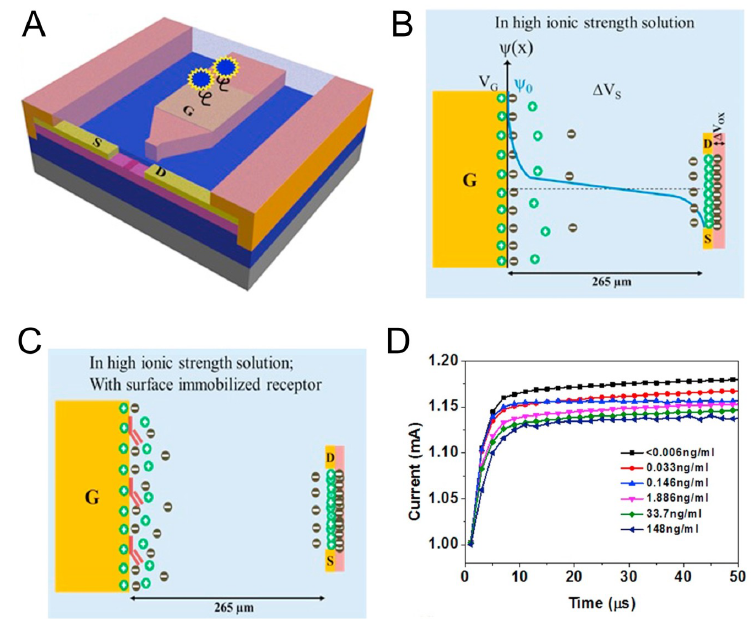
Figure 2. ( A ) Schematic illustration of the AlGaN/GaN High Electron Mobility Transistor (HEMT) sensor consisting of a gate electrode opening and channel opening separated by a fixed distance. ( B ) Potential distribution across the solution when gate voltage and transistor bias are applied. ( C ) Illustration of the charge distribution in the electric-double layer (EDL) gated HEMT structure when the receptor is immobilized on the gate electrode area. ( D ) Current versus time graph for the aptamer based detection of TNI in clinical human serum samples [61]. Table 1. Comparison of the electrochemical (EC)-based biosensor and field-effect transistor (FET)-based for TN detection in terms of the bioprobe, detection method, detection limit, and nanostructure.